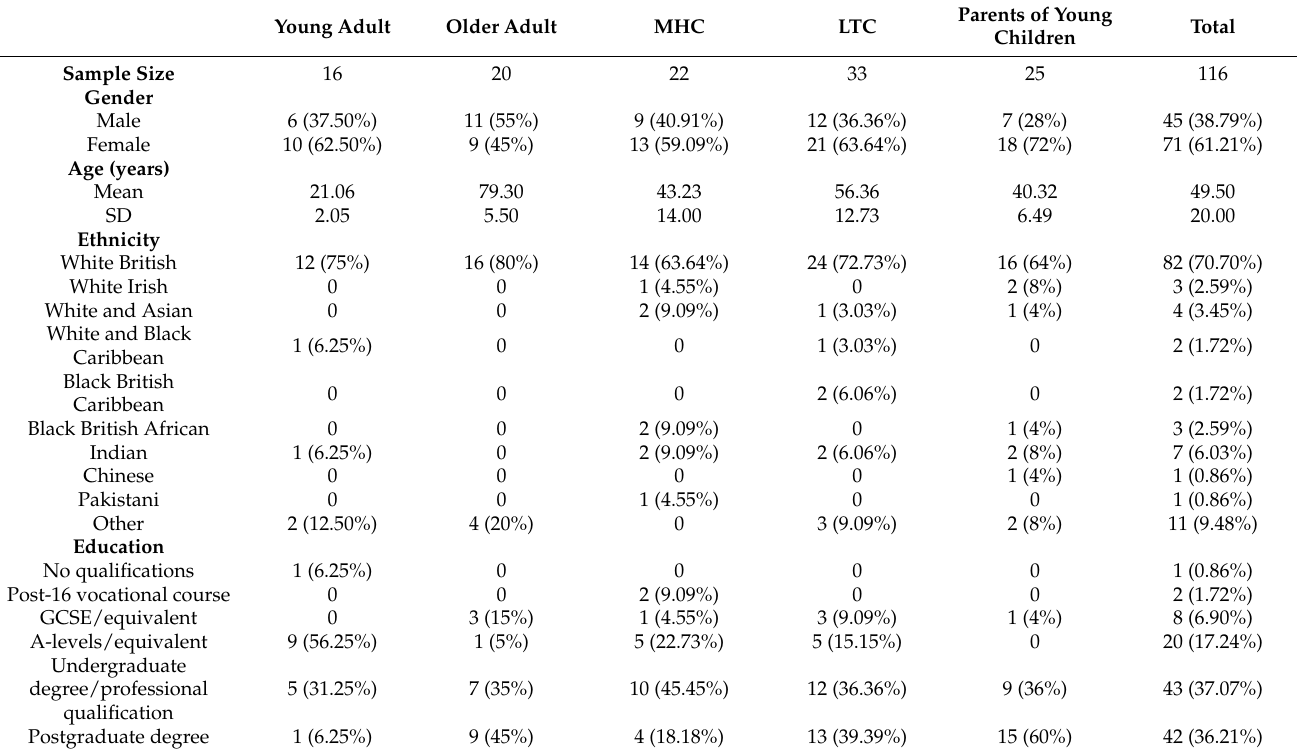
Table 2. Participant demographics for the current